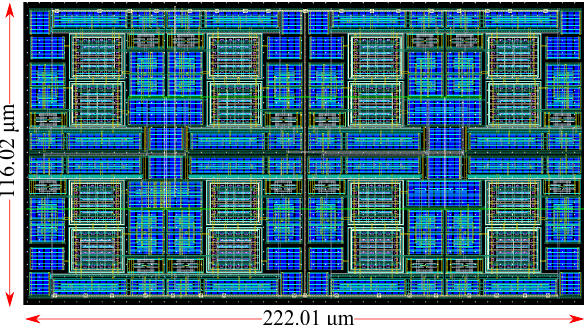
Figure 7. Layout of the proposed classifier